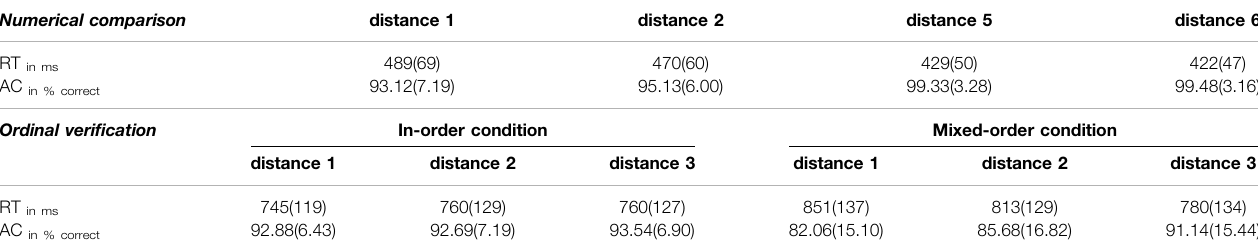
TABLE 1 | Descriptive statistics of mean reaction time and accuracy measures of the computerized tasks. Numerical